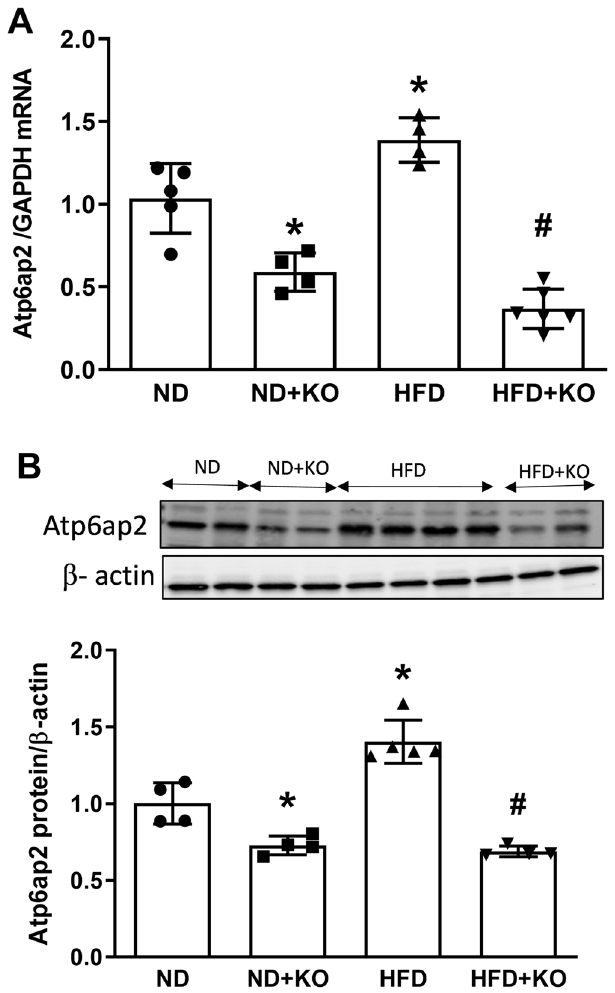
Figure 2. Renal cortical expression of Atp6ap2. Renal cortical mRNA and protein expression of Atp6ap2 after 8 weeks following normal diet (ND) and high fat diet (HFD) in mice with or without Atp6ap2-KO. Data presented as mean ± SEM, * P < 0.05 versus HFD; # P < 0.05 versus HFD + KO, n = 5–6 each